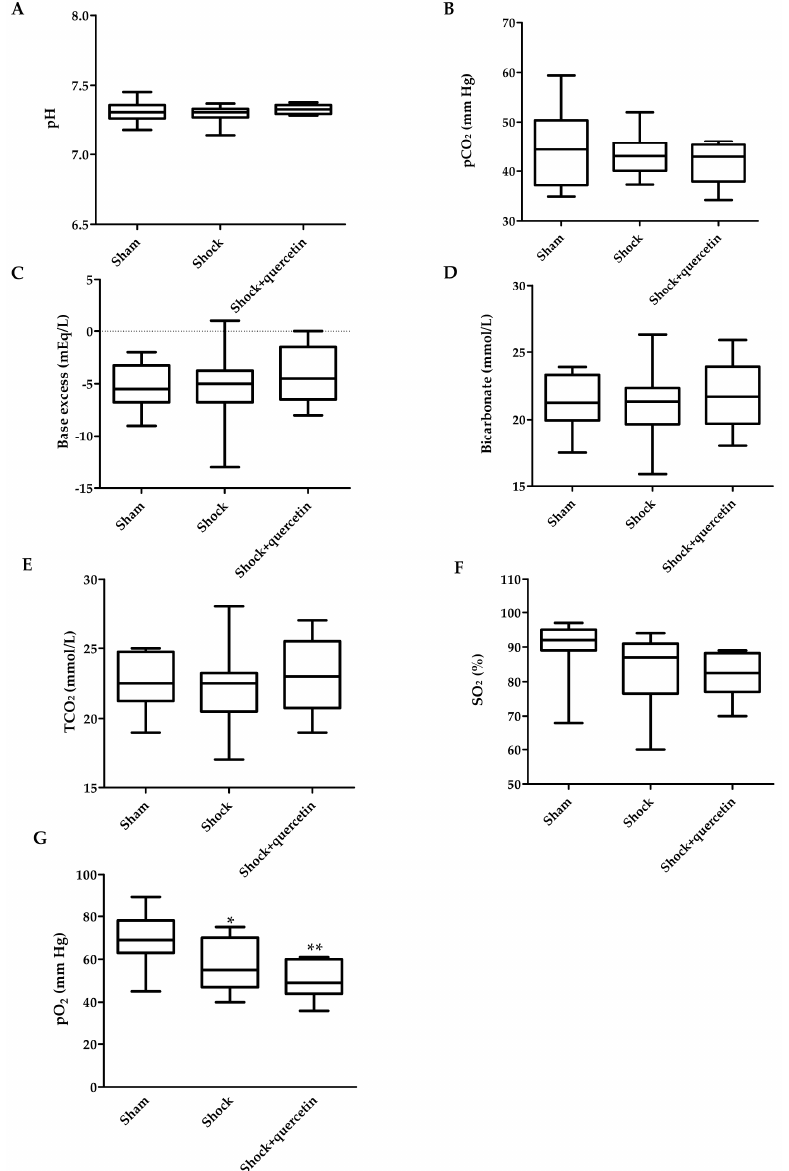
Figure 4. Arterial blood gases. ( A ) Values of pH; ( B ) carbon dioxide partial pressure (pCO 2 ); ( C ) excess base; ( D ) bicarbonate (HCO 3 − ); ( E ) total carbon dioxide concentration (TCO 2 ); ( F ) arterial oxygen saturation (SO 2 ) and ( G ) arterial oxygen partial pressure (pO 2 ) in the sham, shock and shock + quercetin at 180 min (at the end of reperfusion). Box-and-whisker plot showing medians with interquartile range and minimum and maximum values. * p < 0.05 and ** p < 0.01 vs. sham group.